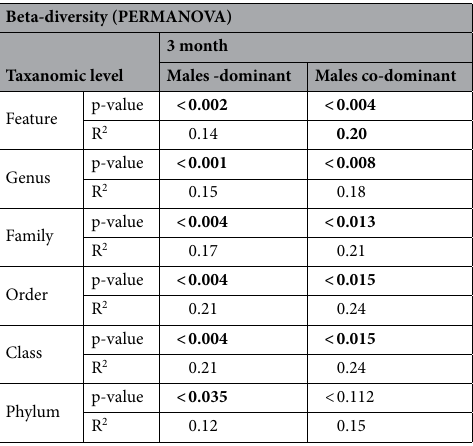
Table 2. Microbiome beta-diversity significantly associated with APOE status in male, but not female, mice. The R 2 values represent the proportion of the variance captured by APOE alleles. The PERMANOVA results were derived from 999 permutations. Values for 5- and 7-month male mice and female mice are contained within Tables S3 and S4. Significance p-values are in bold font.